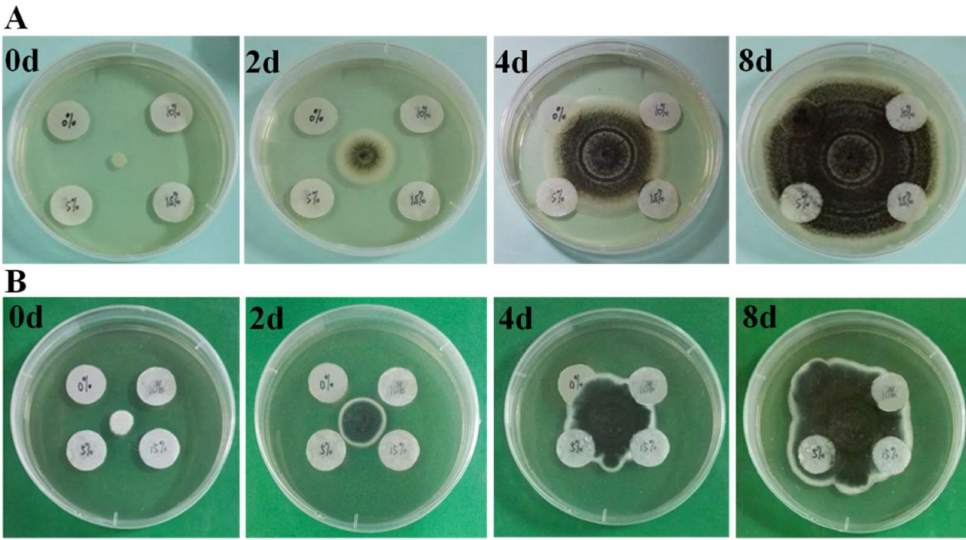
Figure 3. Antifungal effect of papers coated with 0 (left up), 5 (left down), 10 (right up) and 15% (right down) of PBA after incubating with ( A ) A. niger and ( B ) Penicillium sp. for eight